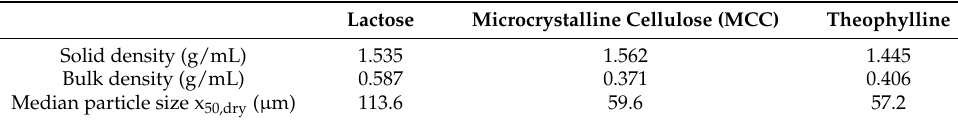
Table 1. Physical and chemical properties (based on own experimental results).